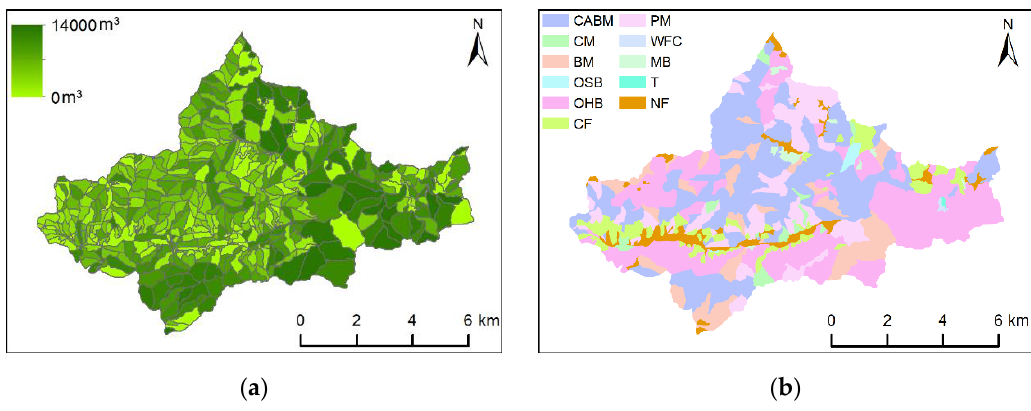
Figure 2. ( a ) Spatial distribution of forest stock volume; ( b ) spatial distribution of forest types. These maps were derived from forestry sub-compartment data in 2016.